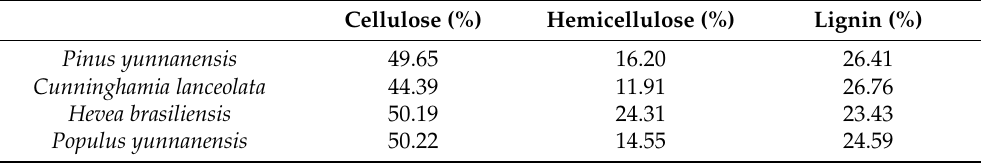
Table 2. The average of relative chemical compositions of different tree species.